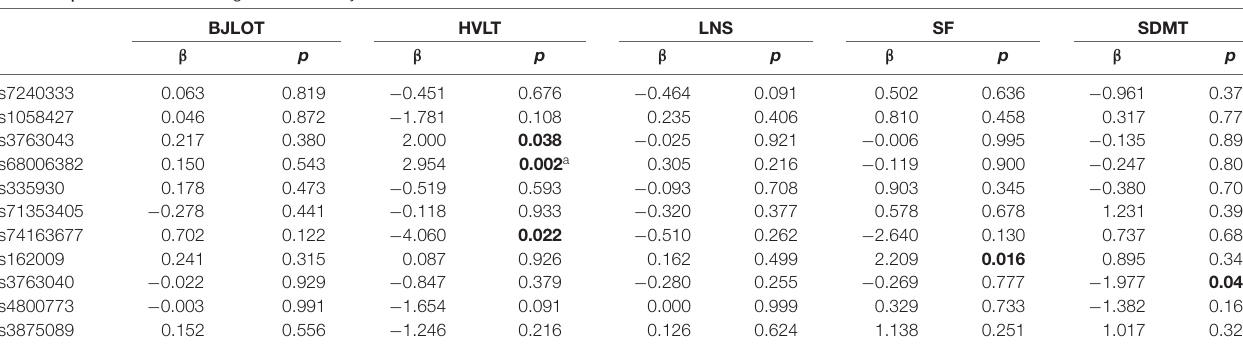
TABLE 5 | AQP4 SNPs and cognition in healthy